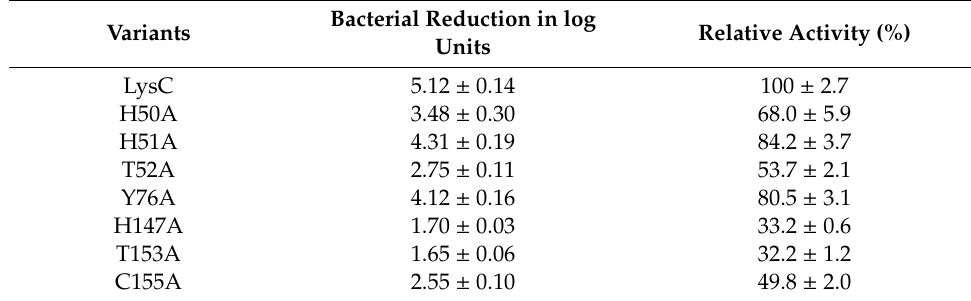
Table 2. Antimicrobial activity of LysC variants. Activities are expressed as bacterial reduction in logarithmic units and as percentage in relation to the native LysC control (average from three replicate measurements ± standard